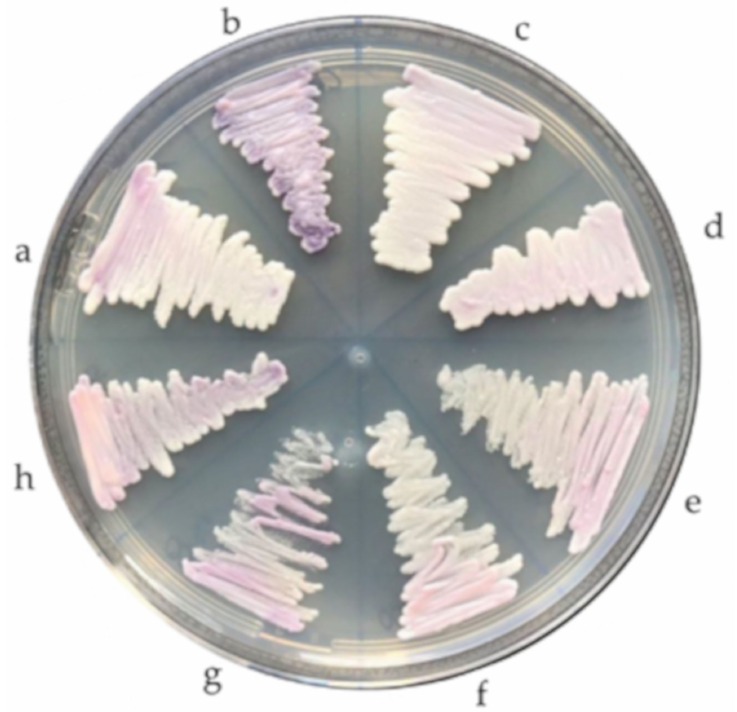
Figure 2. Phenotypic characteristics of Candida haemulonii complex species grown on CHROMagar Candida medium: ( a ) Candida duobushaemulonii , ( b ) Candida pseudohaemulonii , ( c , d ) Candida auris, and ( e – h ) Candida haemulonii